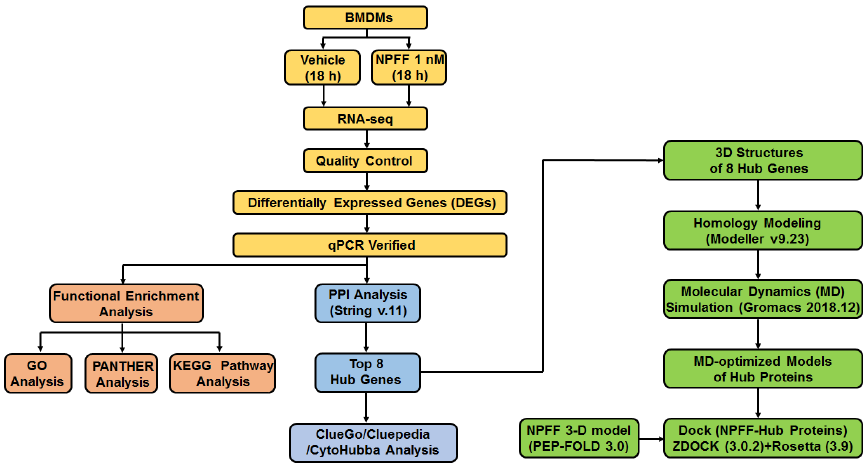
Figure 1. Schematic diagram of the present study.